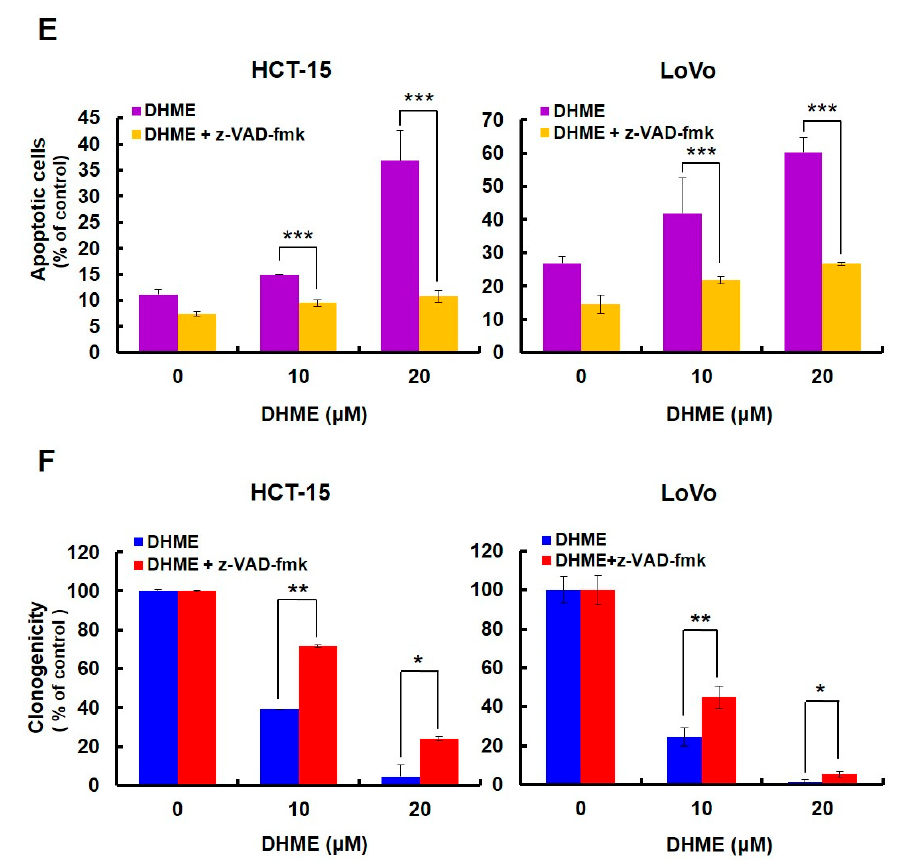
Figure 3. Apoptosis induction is essential for the anti-CRC action of DHME. ( A ) DHME induces poly (ADP-ribose) polymerase (PARP) cleavage. HCT 116, HCT-15, and LoVo cells were treated with DHME (0, 10, or 20 µ M) for 24 h, followed by immunoblotting for the levels of cleaved PARP (c-PARP). The levels of glyceraldehyde-3-phosphate dehydrogenase (GAPDH) served as the loading control. ( B ) DHME enhances the levels of annexin V-positive cell population. Human CRC cell lines treated with DHME (0, 10, 20 μ M) for 24 h were subjected to annexin V/Propidium iodide (PI) dual staining using flow cytometry analysis. Annexin V-positive cells were regarded as cells undergoing apoptosis. The levels of the cell population in each quadrant were expressed as the percentage of total cell population. The horizontal axis denotes the intensity of annexin V, and the vertical axis indicates PI levels. ( C ) Quantitative analysis of DHME-induced CRC cell apoptosis. The annexin V-positive (apoptotic) cell population shown in ( B ) were scored. ( D – F ) Apoptosis blockade by z-VAD-fmk (50 μ M) attenuates DHME-induced apoptosis as well as clonogenicity in CRC cells. The levels of the protein-to-GAPDH ratio relative to DHME-untreated controls were quantitated by ImageJ algorithm and are indicated below each blot. * p < 0.05; ** p < 0.01; *** p < 0.001.